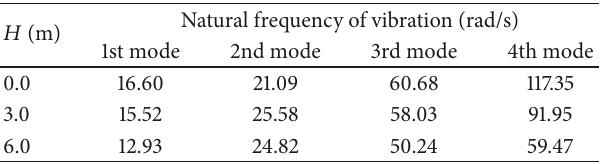
Table 3: Natural vibration frequency of pitched-roof frame. 𝐻 (m) Natural frequency of vibration